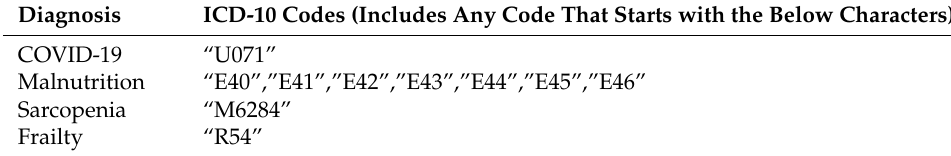
Table A1. International Classification of Diseases (ICD) (10th Edition) diagnosis codes used to identify disease states for a skilled nursing facility US Medicare claim set of specific diagnoses *.